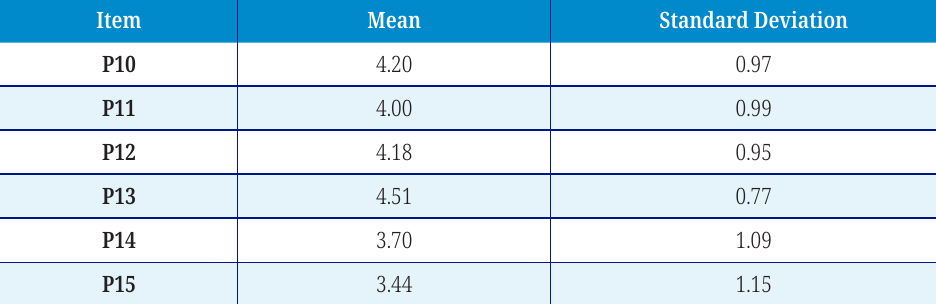
Table 6. Mean obtained by dimension 3 items